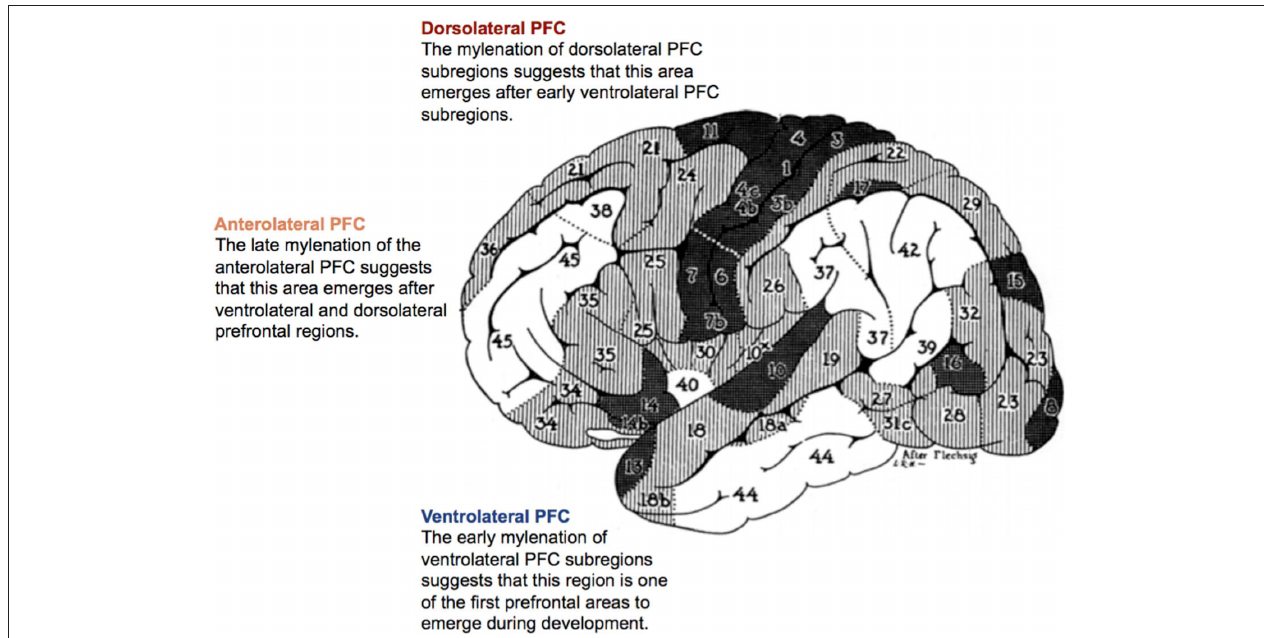
Figure 3 | Ontogenetic map of the prefrontal cortex according to Flechsig (1901, 1920). The numeration of the areas indicates the order of their myelination. Modified with permission from